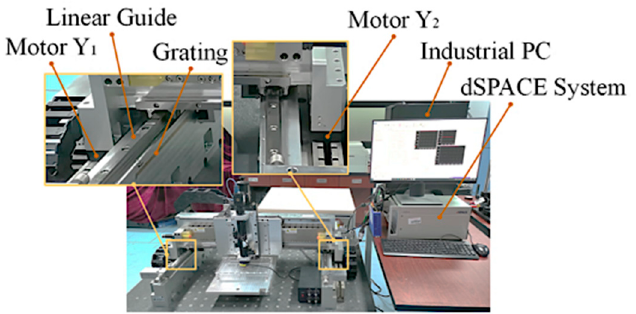
Figure 6. Experimental system.